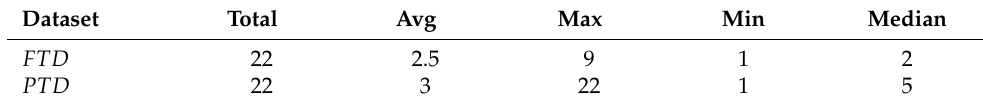
Table 5. Statistical properties of the number of geographical locations.